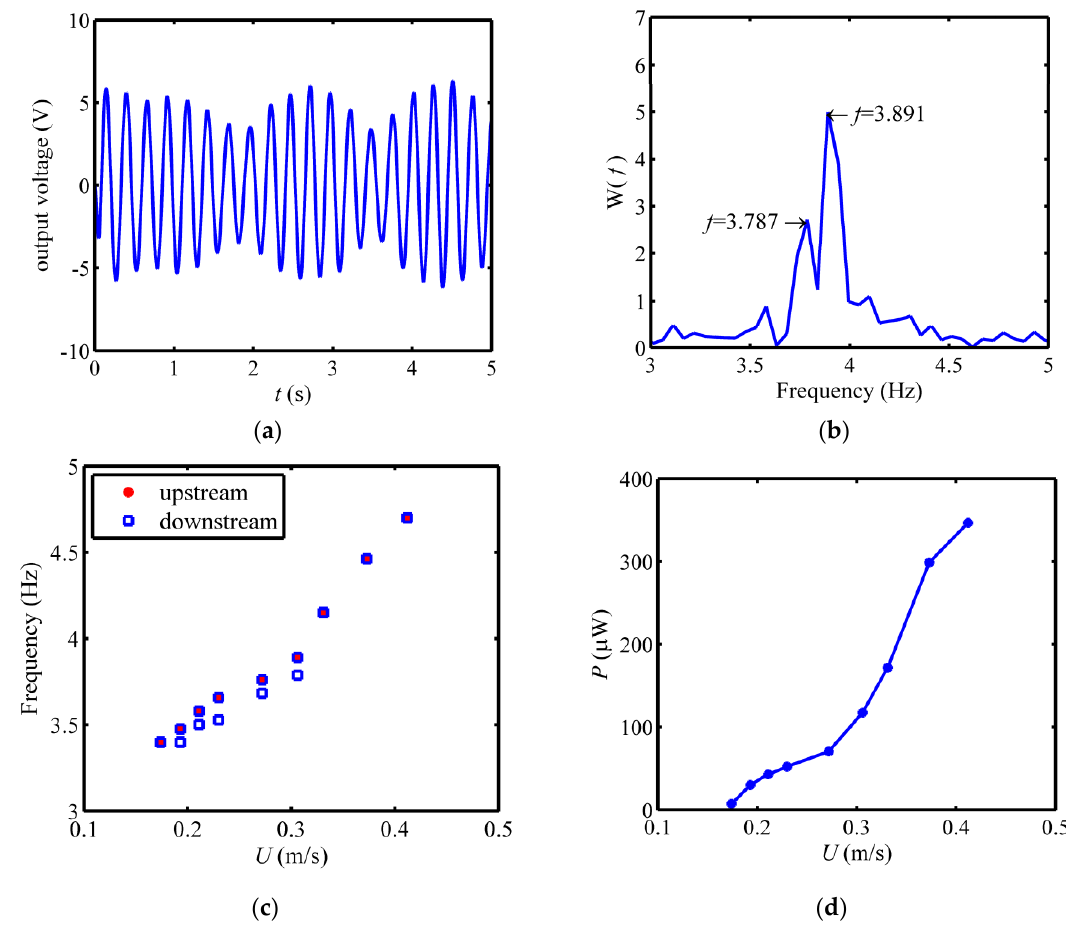
Figure 8. Performance of the downstream harvester at the spacing ratio L / D = 3.3: ( a ) Time history of the output voltage at the water speed of 0.306 m/s; ( b ) Fast Fourier Transform (FFT) analysis of the output voltage at the water speed of 0.306 m/s; ( c ) Comparison between the frequency of vortex shedding from the upstream harvester and that of the downstream harvester; ( d ) Output power of the downstream harvester as a function of the water speed.